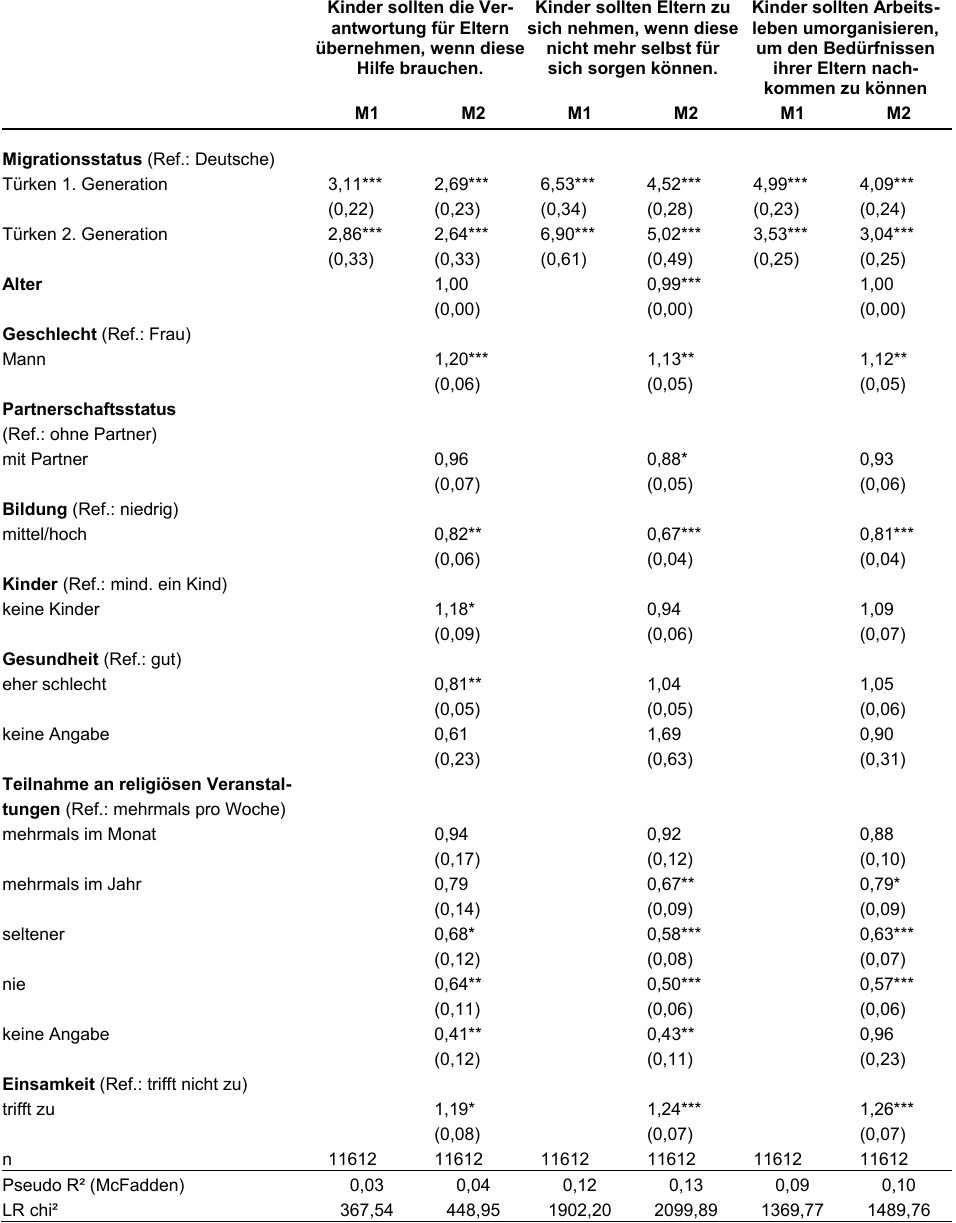
Tabelle 3 : Logistische Regressionsmodelle (OR) zur Zustimmung hinsichtlich zukünftiger Hilfeleistungen/Pflegeübernahme der Eltern Kinder sollten die Ver- antwortung für Eltern übernehmen, wenn diese Hilfe brauchen.